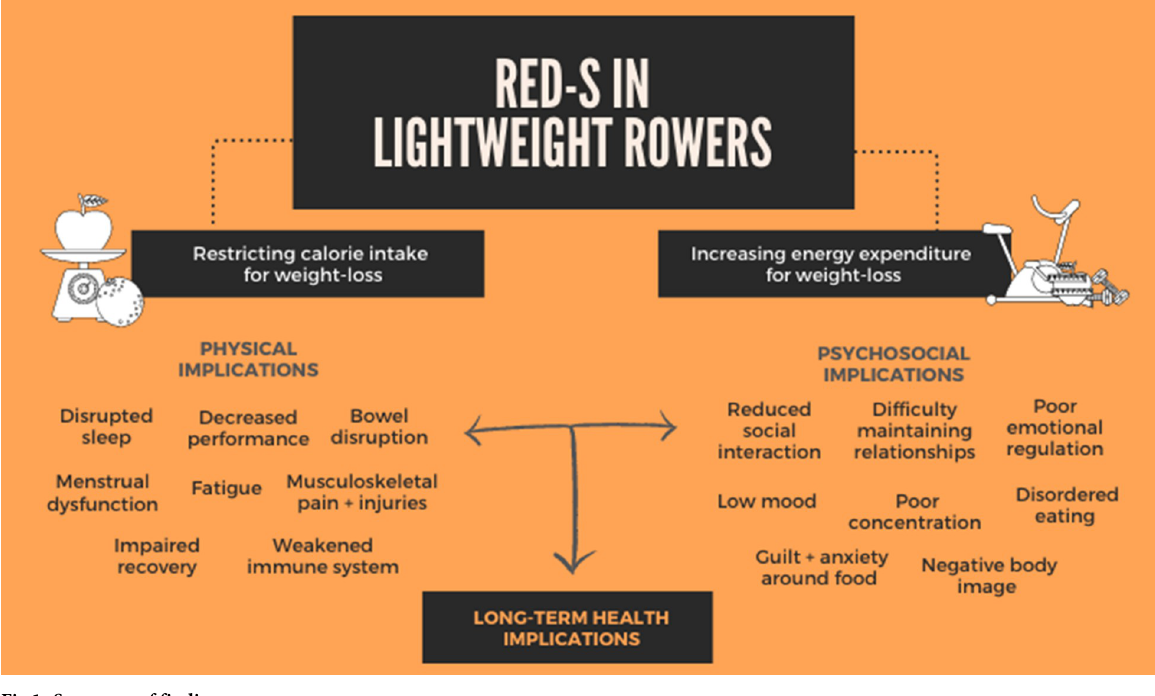
Fig 1. Summary of